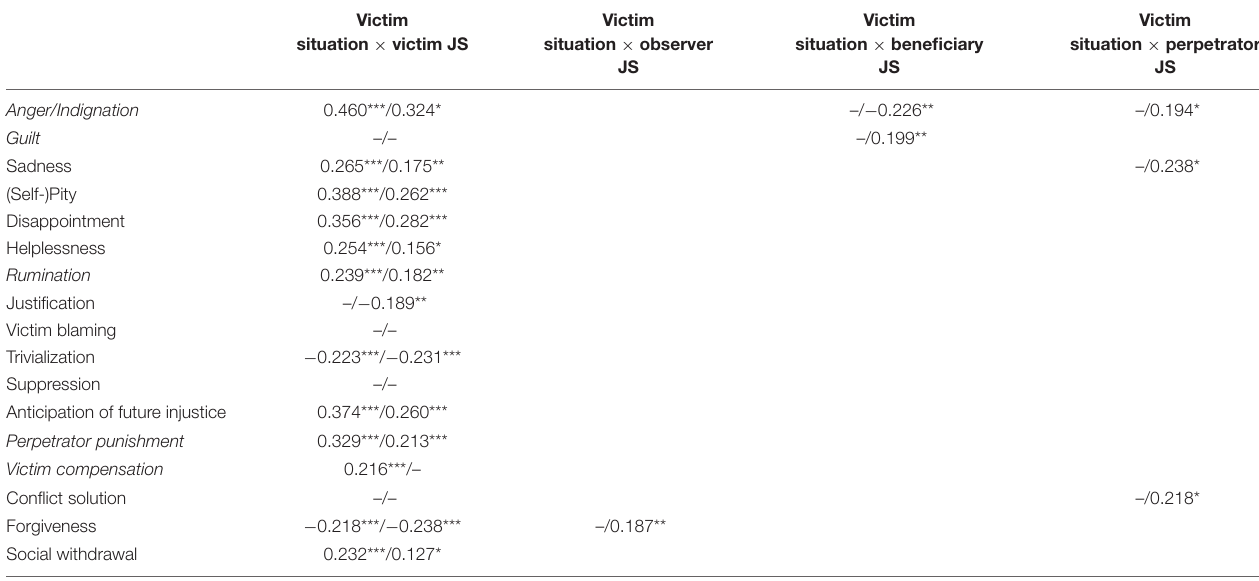
TABLE 5 | Prediction of responses in situations from the victim’s perspective by the JS facets when including only victim JS/all variables.